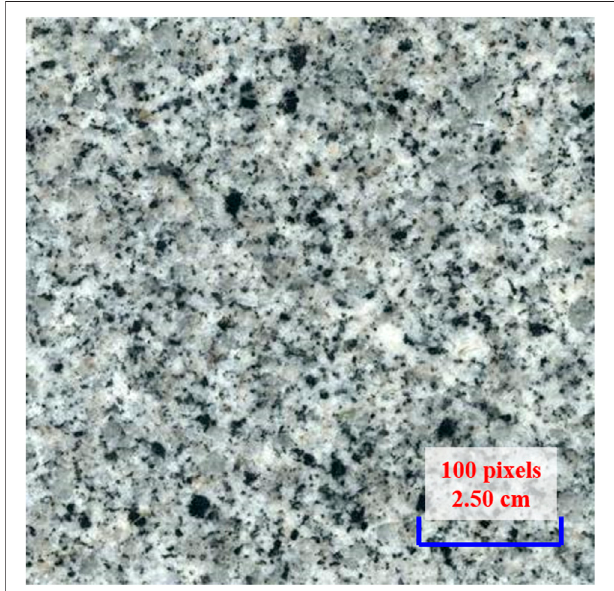
FIGURE 1 | Sesame gray